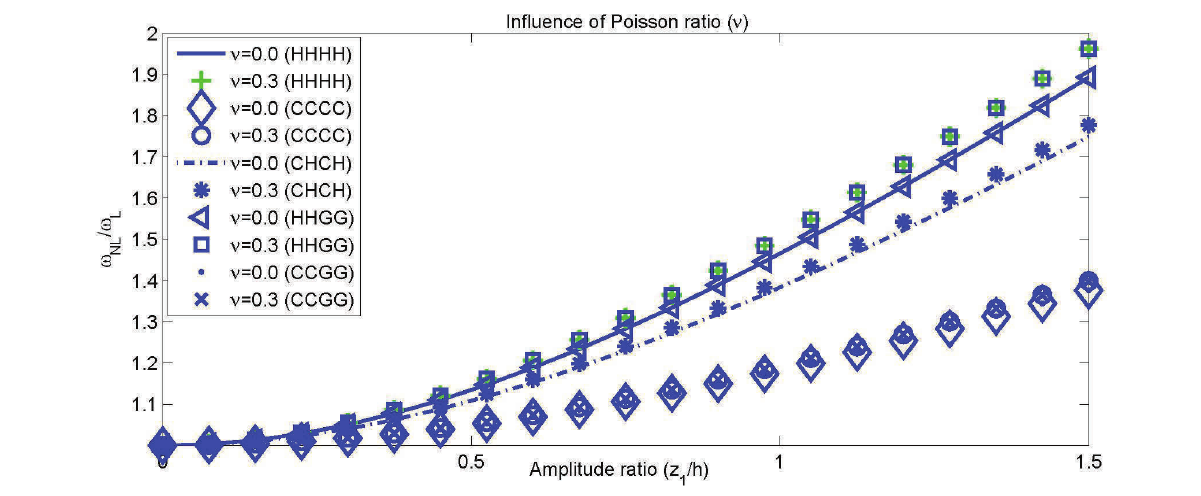
Figure 3. Back-bone curves indicates the influence of aspect ratio . a proposed closed-form solutions for (cid:23) =0.3